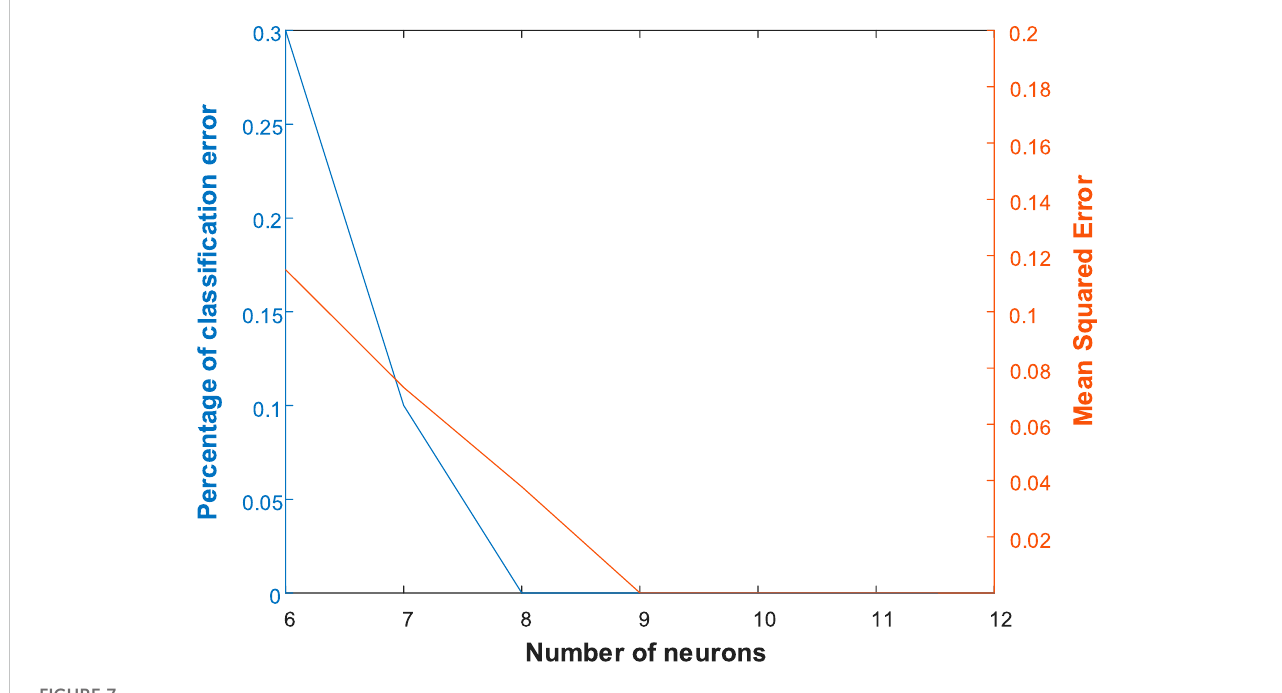
FIGURE 7 The relationship between the number of hidden nodes and classi fi cation error, MSE.